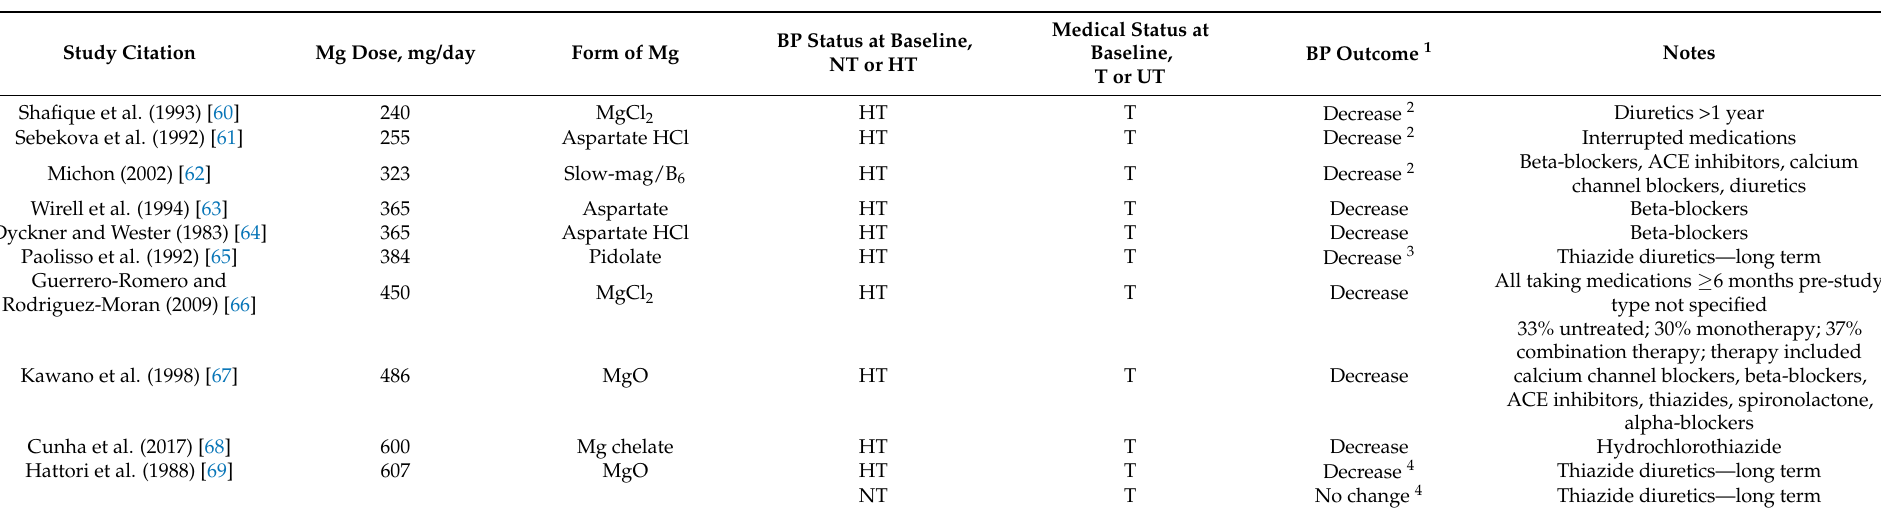
Table 2. Summary of magnesium supplementation studies for blood pressure in Uncontrolled Hypertensives (subjects treated with antihypertensive medications, hypertensive at baseline).